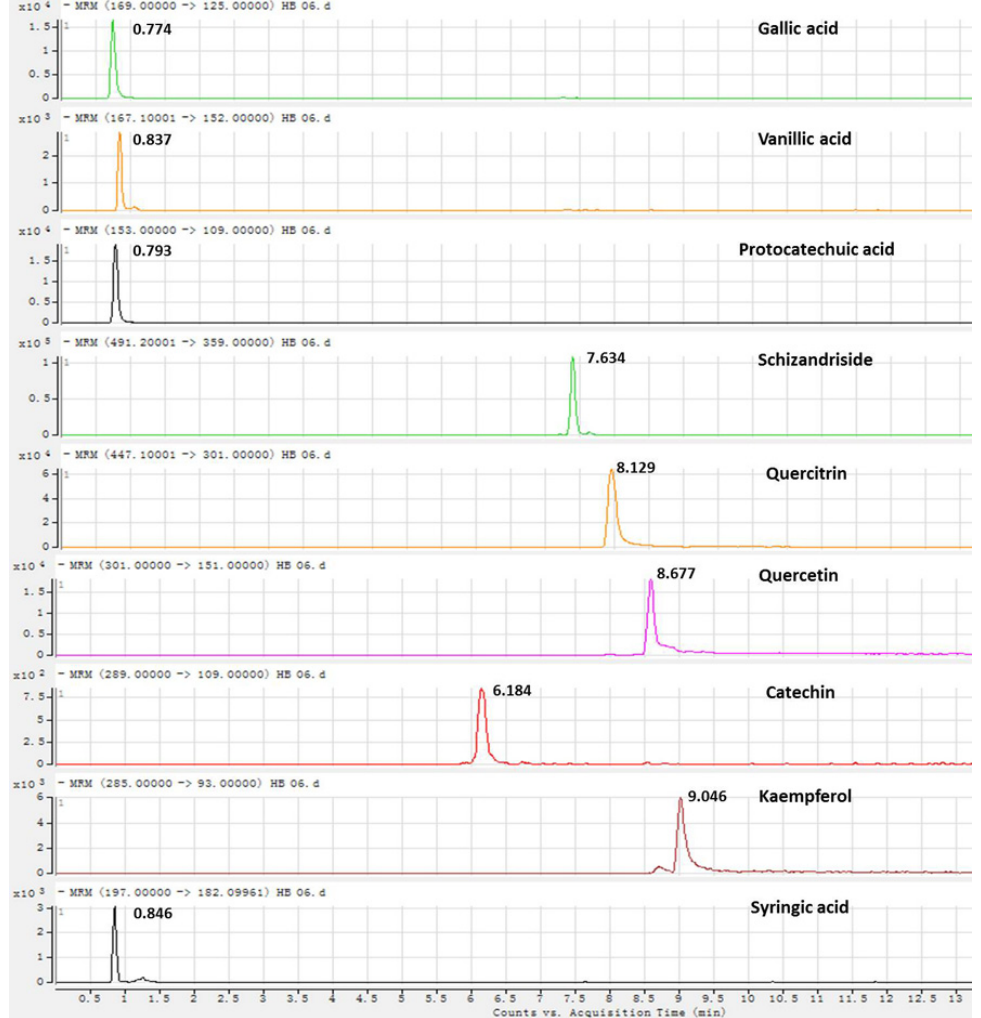
Figure 1. The RRLC-MS/MS analysis MRM chromatograms of the 9